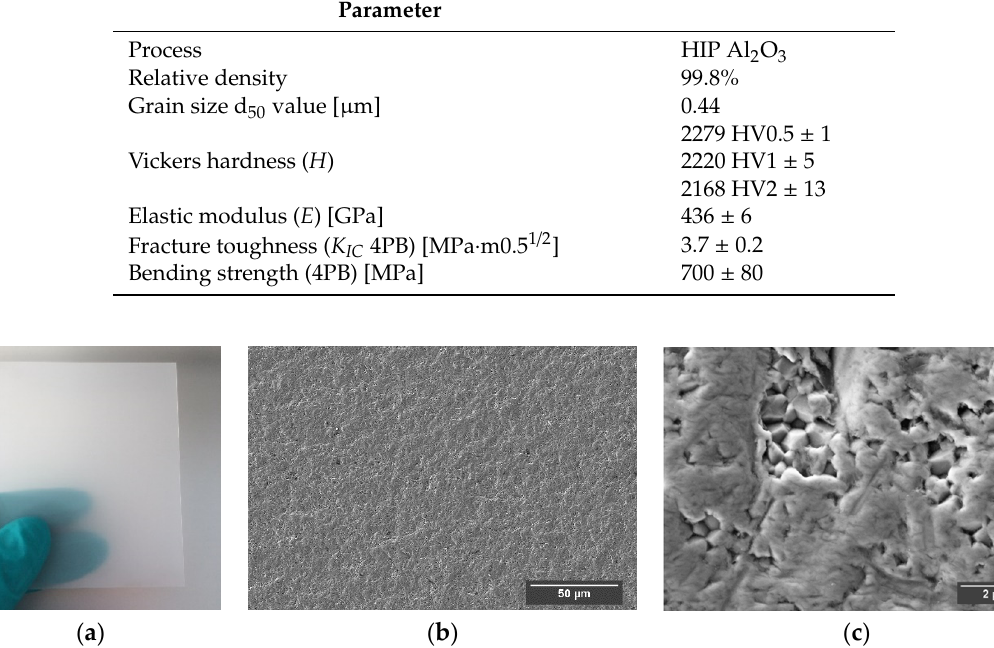
Figure 2. Translucent multi ‐ wire sawn alumina ceramic wafer from the feasibility study: ( a ) dimensions: 80 mm × 65 mm × 0.5 mm; Ra = 0.3 μ m; ( b ) and ( c ) FESEM images of the as cut wafer